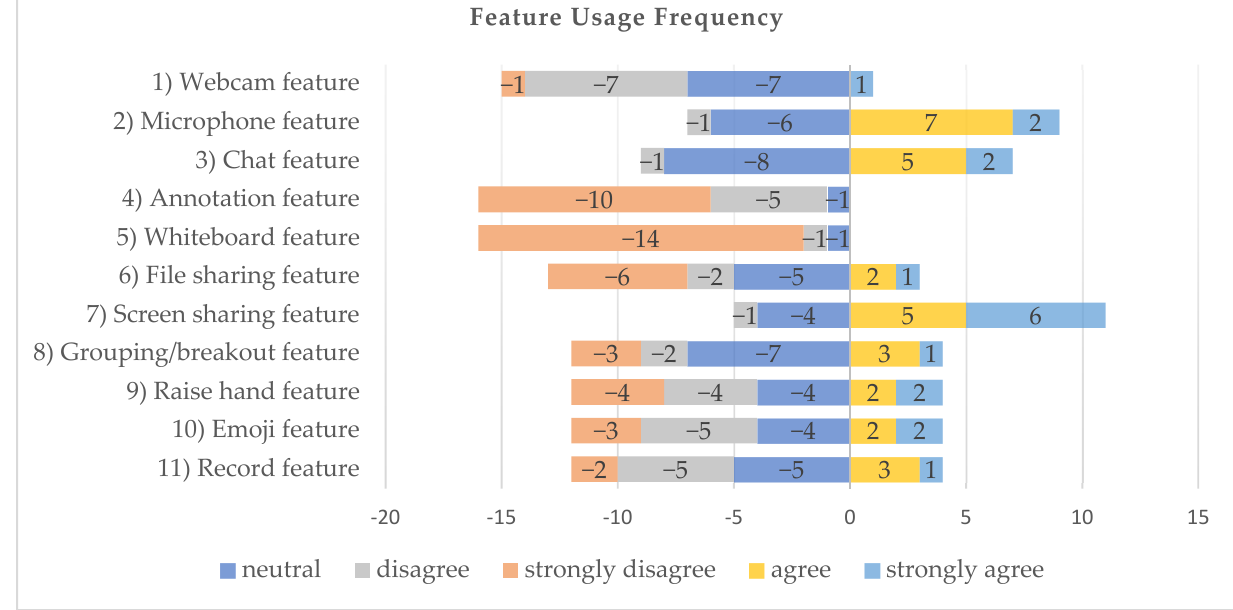
Figure 3. Distribution of users’ usage frequency of features on virtual conferencing tool.